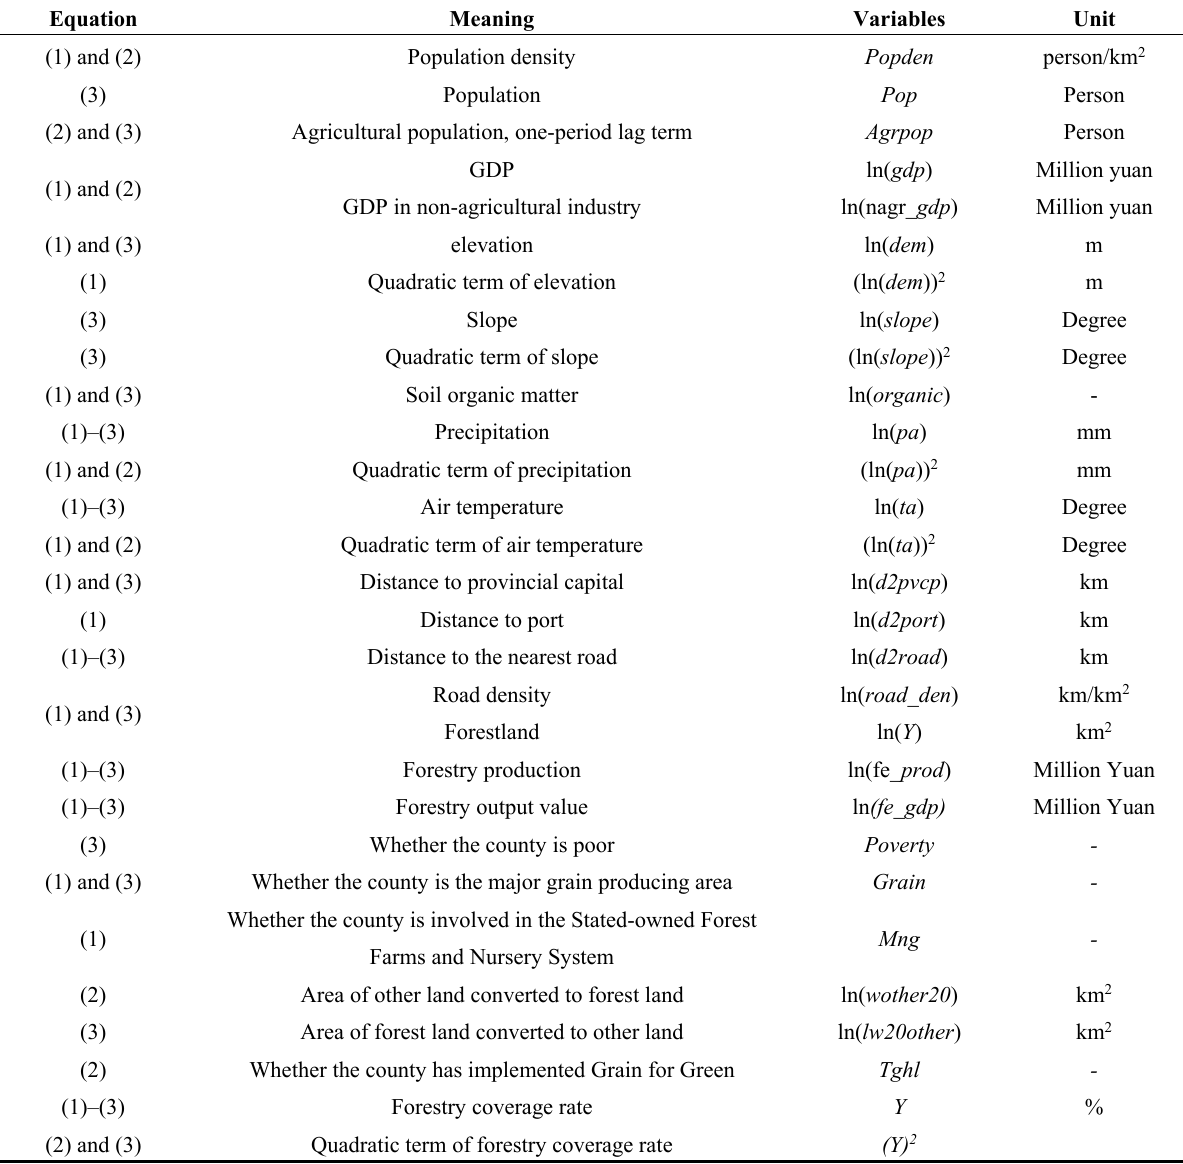
Table 1. Variables in the driving mechanism analysis in a typical deforestation and afforestation